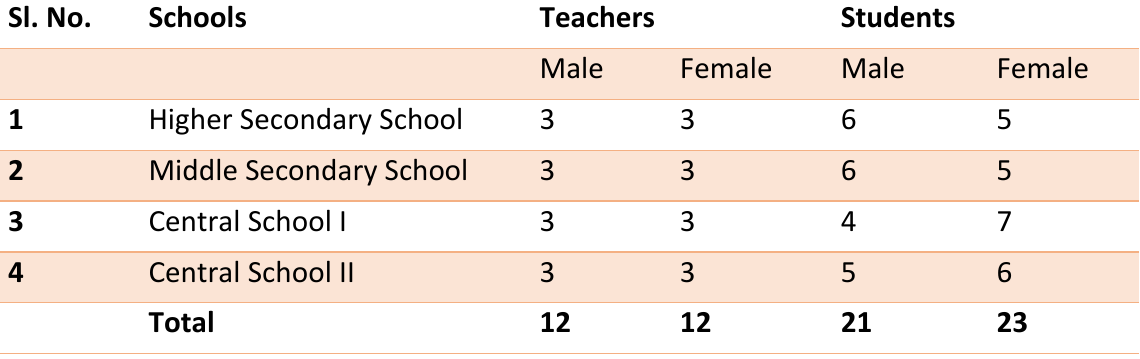
Table 1: Number of teachers and students for the FGD Sl.